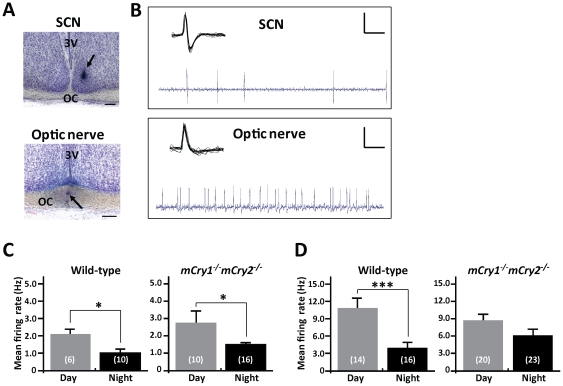
Temporal differences in spontaneous neuronal firing activity in the SCN and optic nerve of wild-type and mCry1−/− mCry2−/− mice.
A, Representative photographs show the recording sites of the SCN (top panel) or optic nerve fibers (bottom panel). Arrow-heads indicate the typical recording positions. 3V, 3rd ventricle; OC, optic chiasm. Scale bars indicate 200 µm. B, Representative “light-activated” neuronal firings recorded in the SCN neuron and the optic nerve fibers of mice are shown. Each inset shows the characteristic waveform of the spike. Vertical calibration bars, 0.5 mV; horizontal calibration, 0.1 sec (oscilloscope trace) and 10 msec (inset). C and D, Day–night differences in the frequencies of spontaneous neuronal firing activity in the SCN (C) and optic nerve (D) of wild-type and mCry1−/− mCry2−/− mice. Histograms depict data as mean ± SEM; the number of animals is shown in parentheses. * P<0.05, *** P<0.001, Student's t-test.